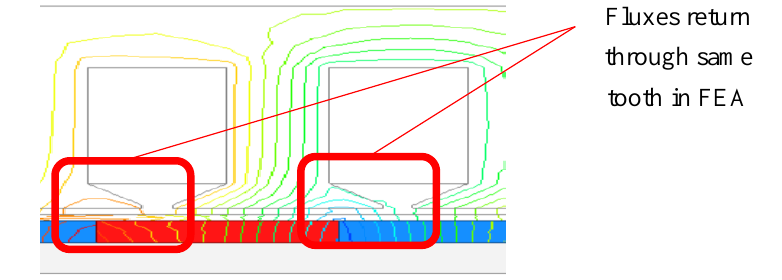
Figure 29. Returning Fluxes Through Same Tooth at 10 mm Axial Displacement in FEA.